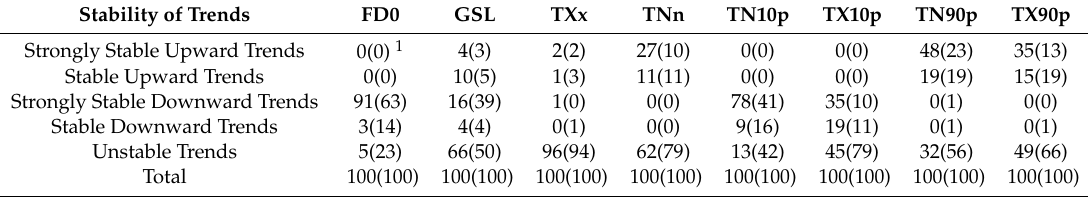
Table 3. Percentage of stations with stable trends in extreme temperature indices